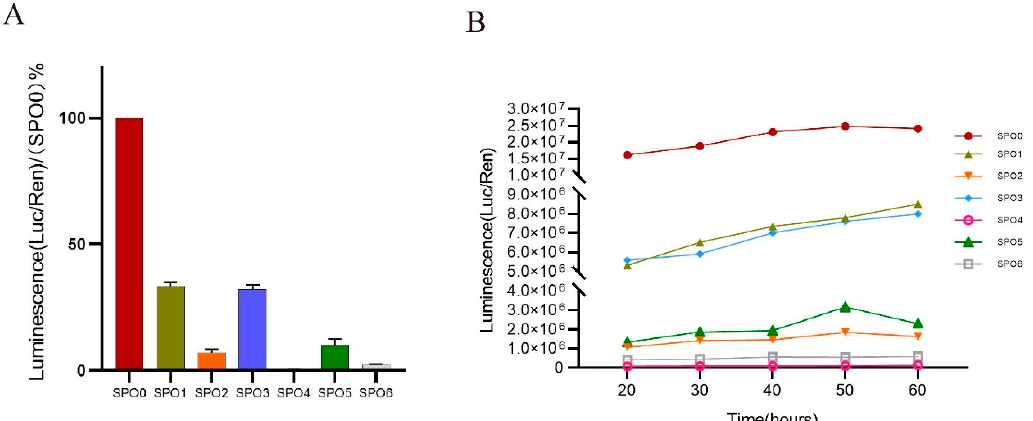
Figure 5. Transcription activity of 5’ UTR truncations. ( A ) Relative luciferase activity obtained from the different constructs. SPO1 to SPO6 are located in 5’ UTR . SPO1 (c.-490 to c.-360), SPO2 (c.-360 to c.-1), SPO3 (c.-490 to c.-401), SPO4 (c.-401 to -360), SPO5 (c.-490 to c.-441), and SPO6 (c.-441 to c.-